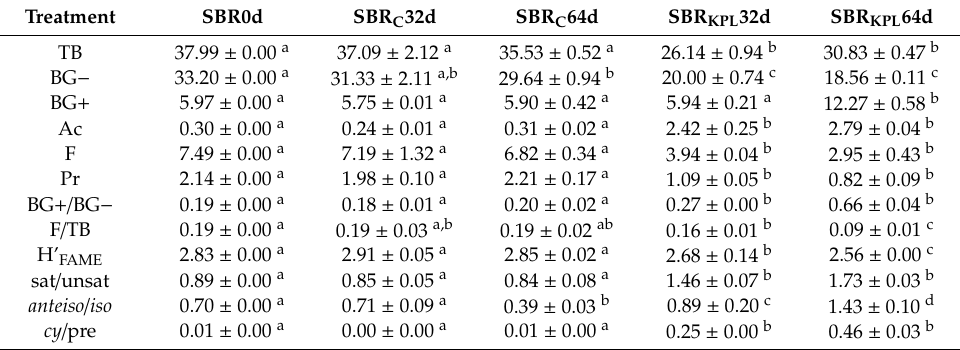
Table 6. The percentages of distinct FAME markers, H’, sat / unsat, anteiso / iso , and cy / pre ratio for the untreated AS and treated with the